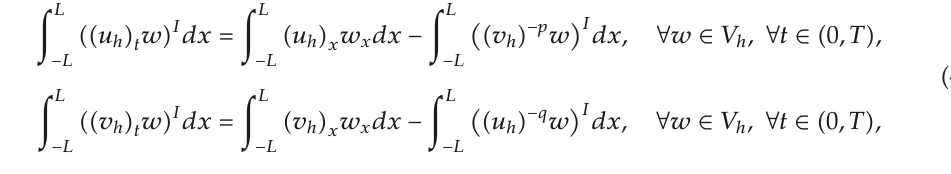
The semidiscrete approximation (cid:5) u h (cid:5) t (cid:6) , v h (cid:5) t (cid:6)(cid:6) ∈ V h obtained by the finite element method with mass lumping is defined